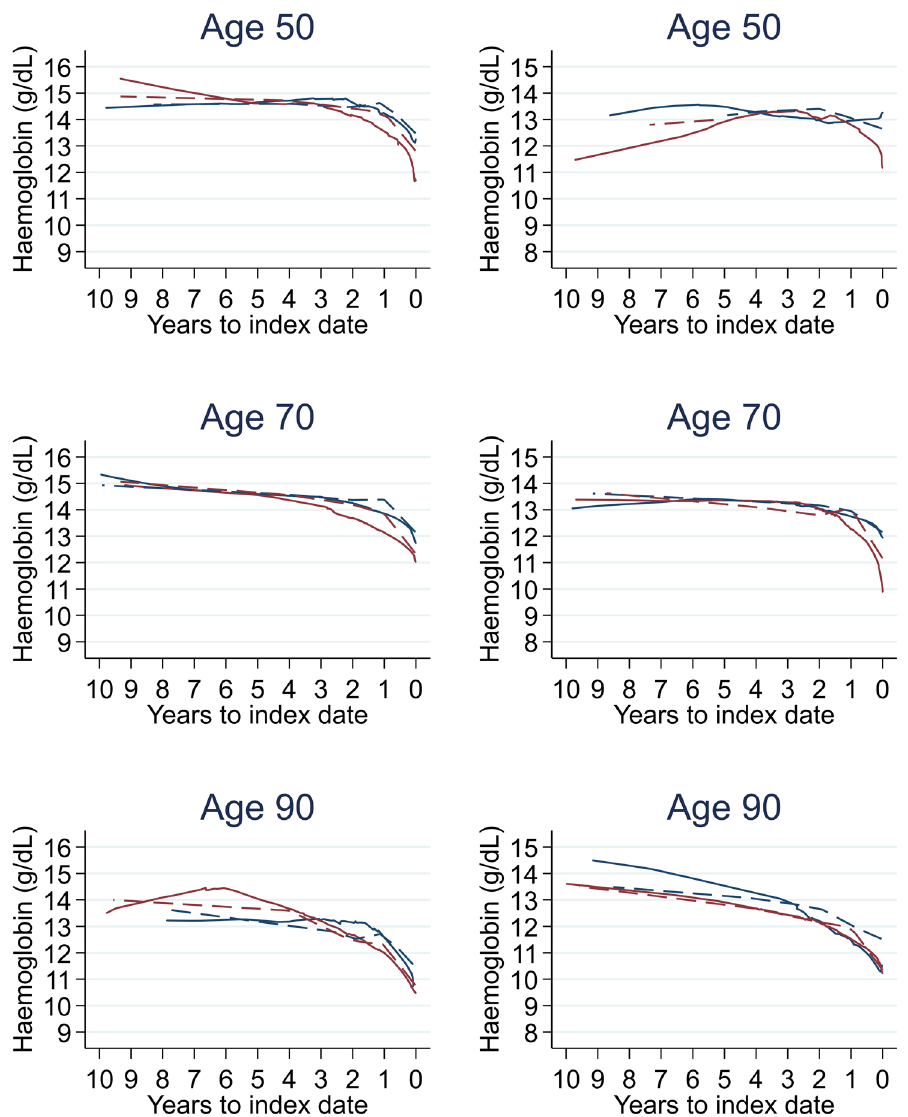
Figure 21. Haemoglobin trends between Duke’s A and D tumour stage by age at index date 1,2 . 1 Index date was the date of diagnosis for cases and a randomly selected date in the patient’s study period for controls. 2 LOWESS trends are age (+/- 3 years) and modelled (fixed effects) trends are taken at that specific age. Legend: males (left) and females (right). Stage A (blue line) and Stage D (red line). LOWESS trend (solid line) and modelled trend (dashed